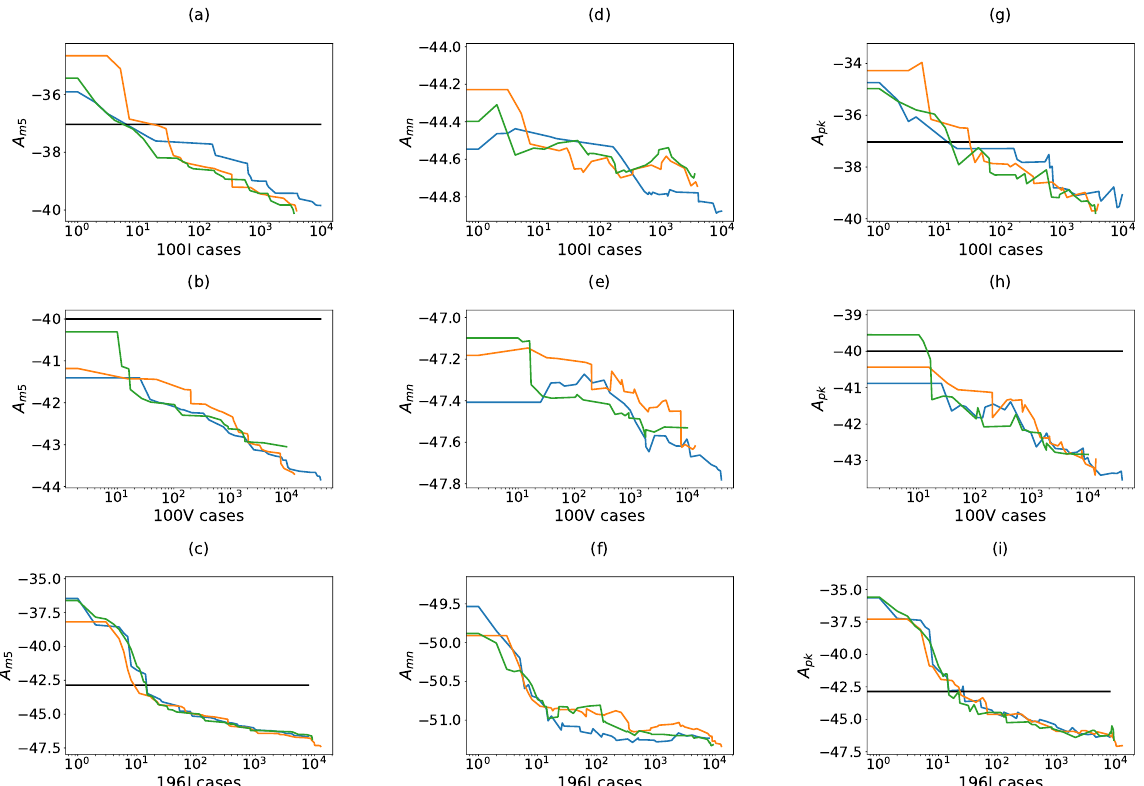
Figure 11. Combined fitness function. Each row analyses the evolution of the dynamic range in one specific configuration. For 100I: ( a ) A m 5 , ( d ) A mn , ( g ) A pk . For 100V: ( b ) A m 5 , ( e ) A mn , ( h ) A pk . For 196I: ( c ) A m 5 , ( f ) A mn , ( i ) A pk . For each configuration three different evolution processes are presented (colors blue, orange and green). In the figures where A pk or A m 5 are presented, the threshold line TH A has been m 5